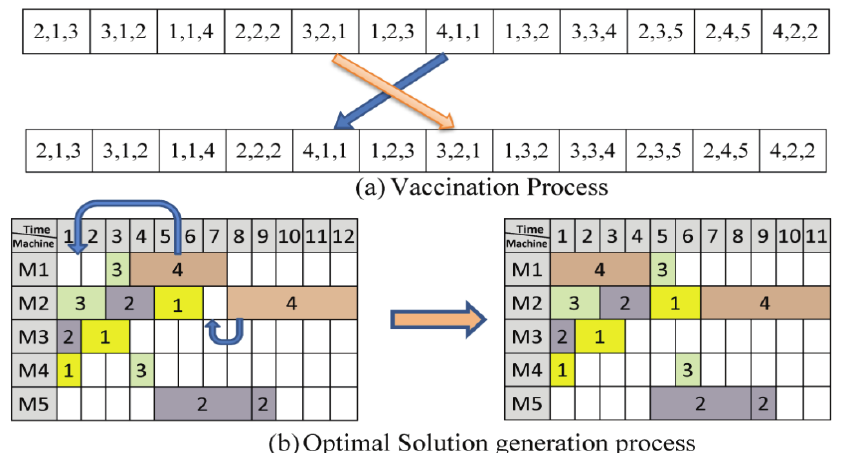
Fig. 2 Optimal solution after vaccination for iteration